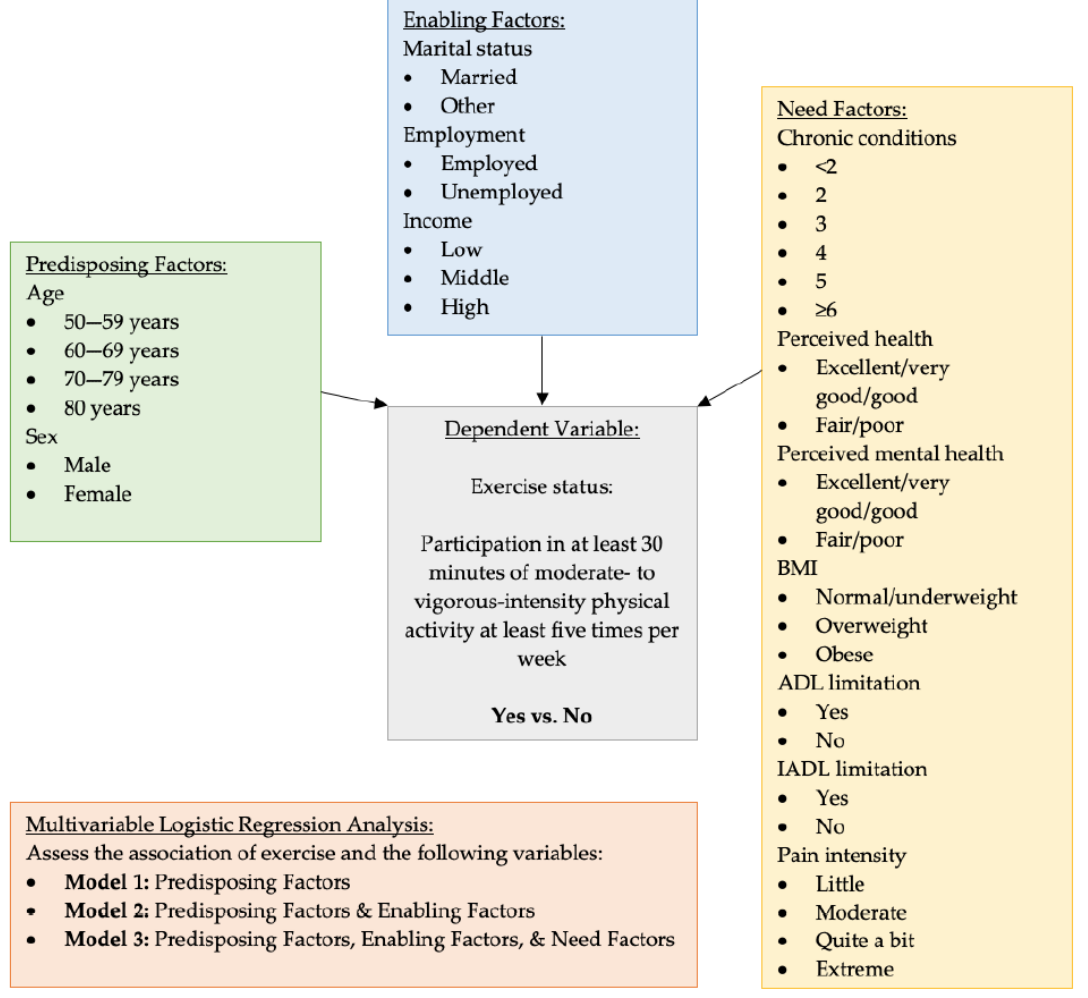
Figure 1. Overview of the statistical analysis approach. BMI = body mass index; ADL = activity of daily living; IADL = instrumental activity of daily living. Predisposing, enabling, and need factors developed by adapting Andersen’s Behavioral Model [31].